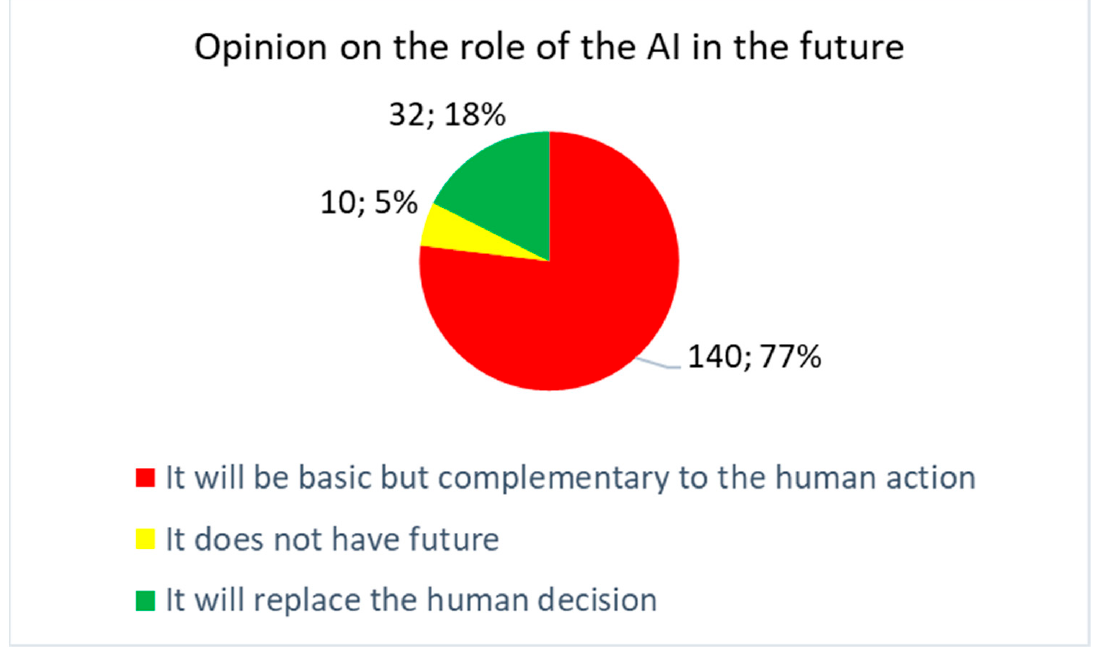
Figure 5. Answers to the multiple choice question #18: “What is your opinion about the future of AI in digital radiology after the COVID-19 pandemic?”